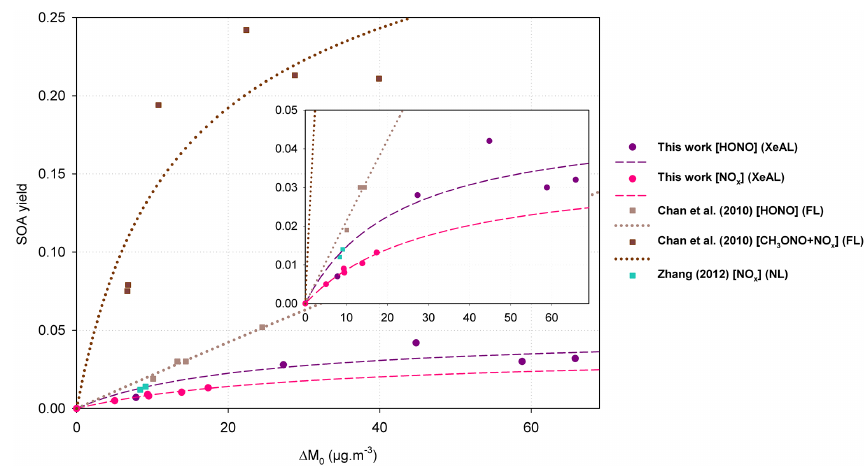
Figure 7. SOA mass yield curves from MACR photooxidation experiments in the presence of NO x carried out by Chan et al. (2010) and Zhang et al. (2012) compared with the present study. An effective density of 1.4gcm − 3 was used for conversion to mass of all our volume- based measurements. Molecules in square brackets are OH sources used. Light sources used are specified in parentheses (XeAL: xenon arc lamps; FL: fluorescent lamps; NL: natural light). The parameters determined for the two products model (Odum et al., 1996) in our study are, for experiments with NO x as OH source: α 1 = 3 . 6 × 10 − 2 ; K om , 1 = 3 . 2 × 10 − 2 ; α 2 = 2 . 6 × 10 − 11 ; K om , 2 = 1 . 63 × 10 − 9 . For experiments with HONO as OH source, these parameters are: α 1 = 4 . 83 × 10 − 2 ; K om , 1 = 4 . 35 × 10 − 2 ; α 2 = 6 . 2 × 10 − 2 ; K om , 2 = 8 . 47 × 10 − 10 .